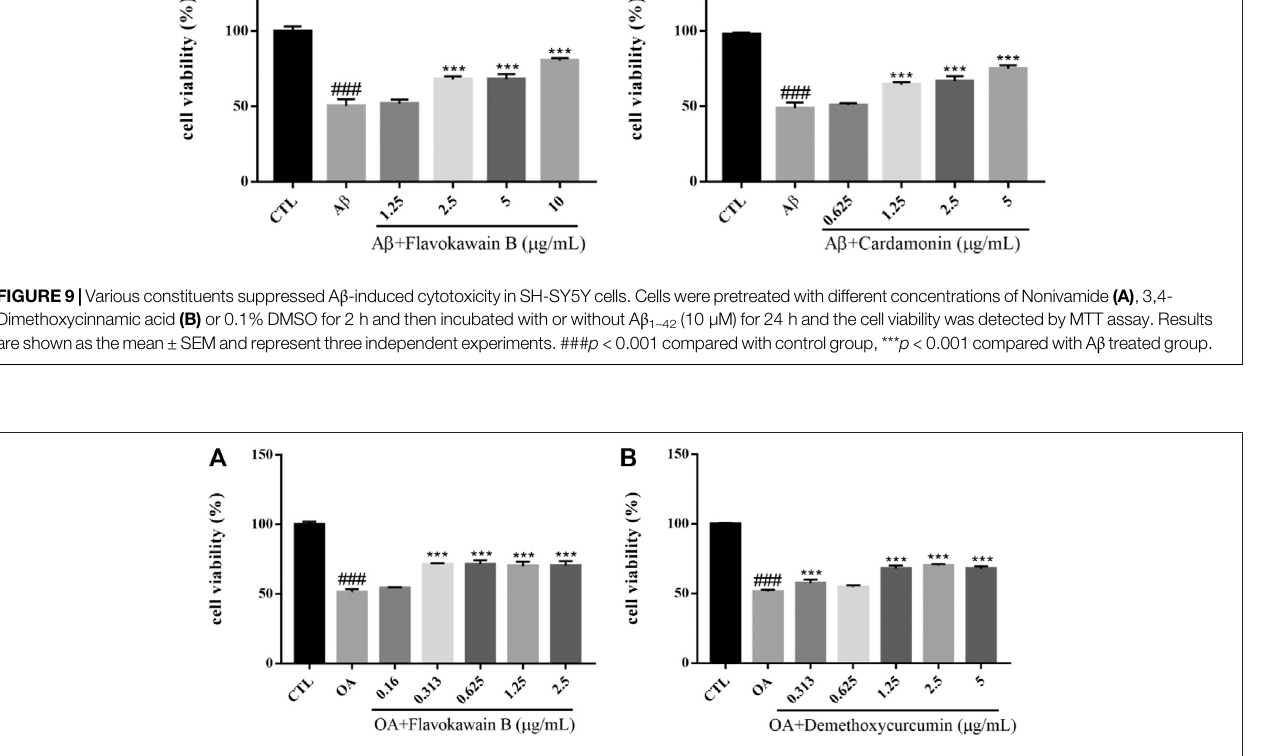
FIGURE10| VariousconstituentssuppressedOA-inducedcytotoxicityinSH-SY5Ycells.Cellswerepre-treatedwithdifferentconcentrationsofFlavokawainB (A) , Demethoxycurcumin (B) or 0.1% DMSO for 2 h and then incubated with or without OA (0.2 μ M) for 24 h and the cell viability was detected by MTT assay. Results are shown as the mean ± SEM and represent three independent experiments. ### p < 0.001 compared with control group, *** p < 0.001 compared with OA treated group.